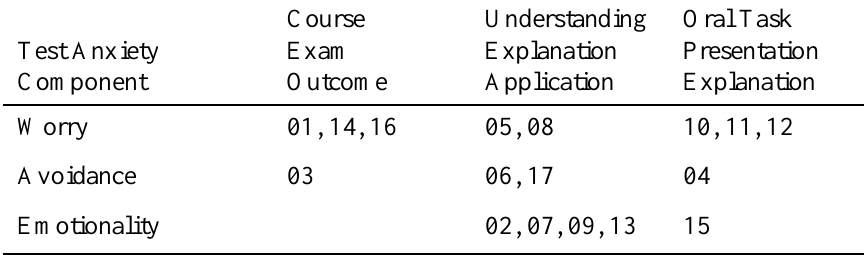
WAESTA items assessing relevant anxiety reactions to statistically loaded task features and course